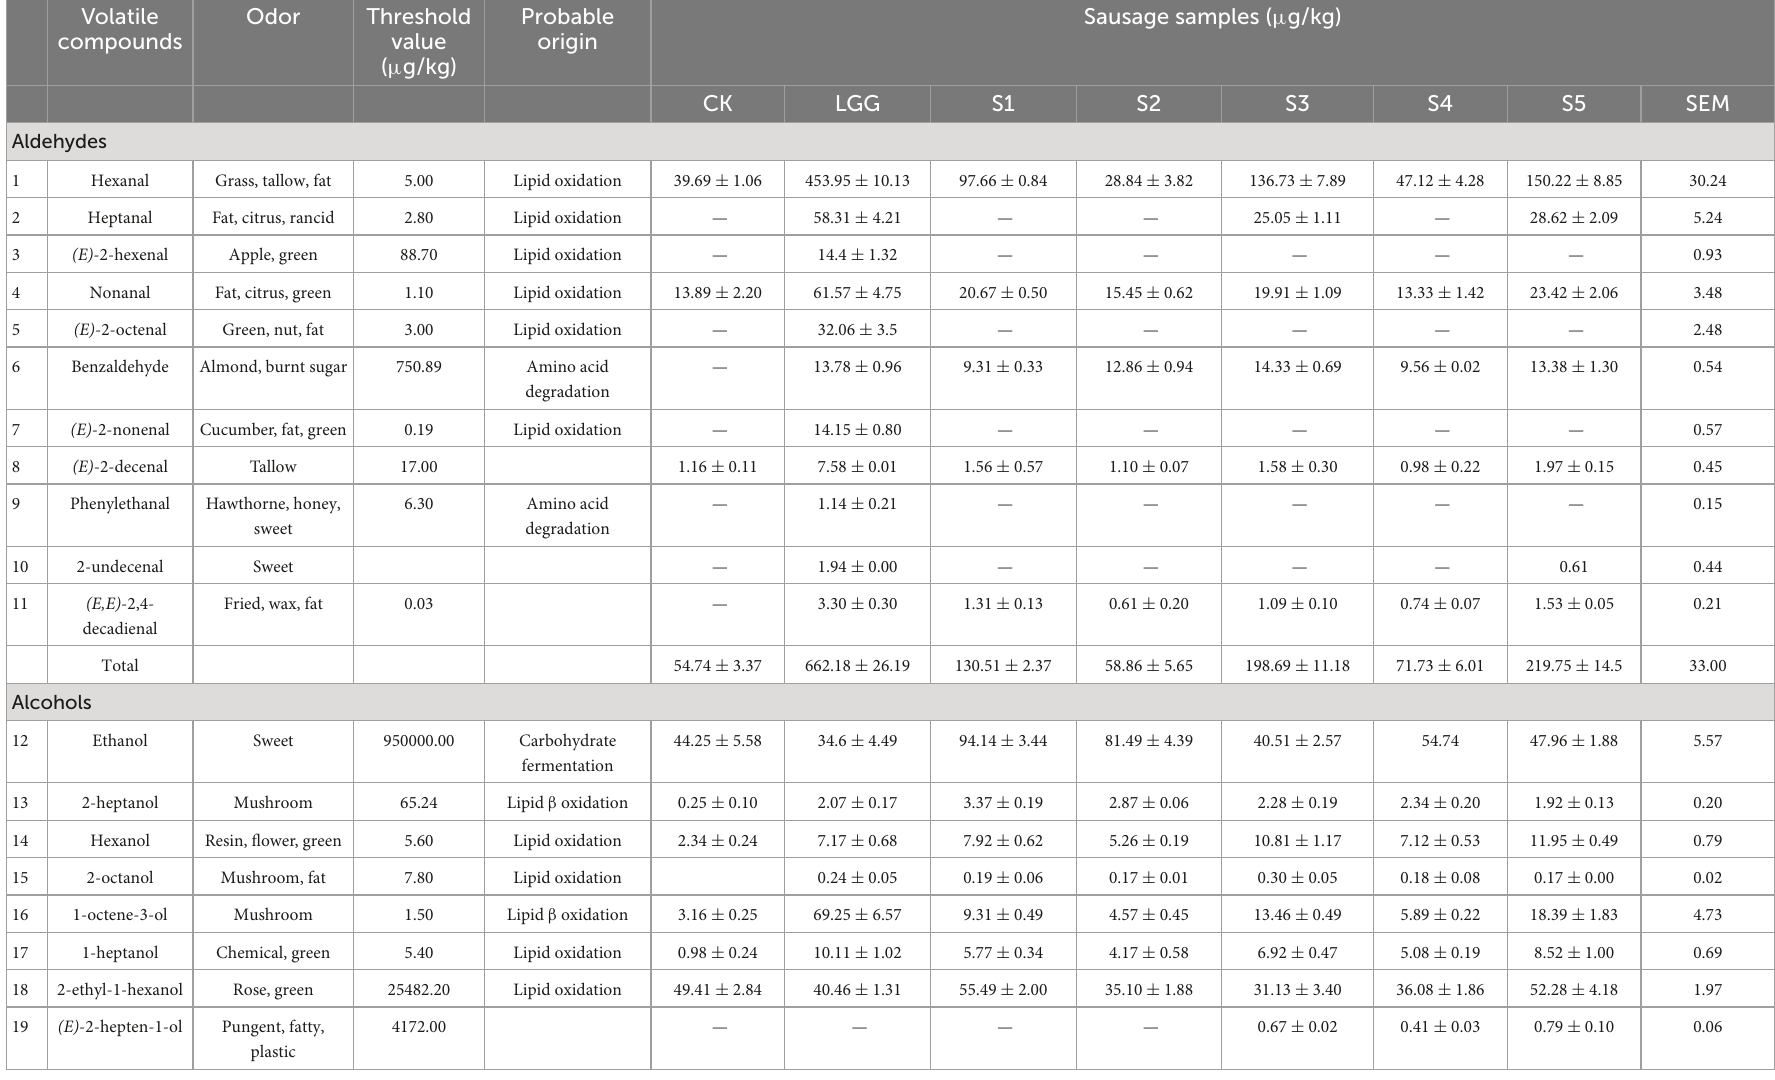
TABLE 4 Changes of volatile flavor substances content in different fermented sausage